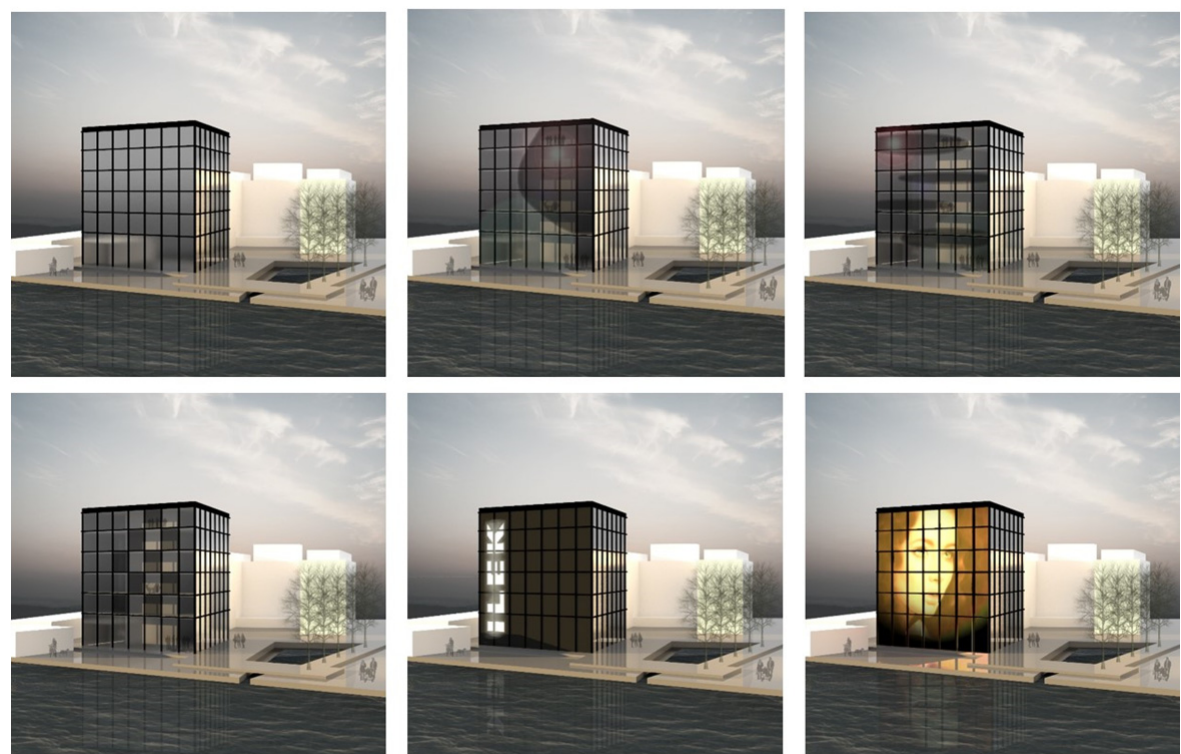
Fig. 10 Application possibilities of the structured adaptive glazing in a fully glazed façade. Renderings: S. Leistner,